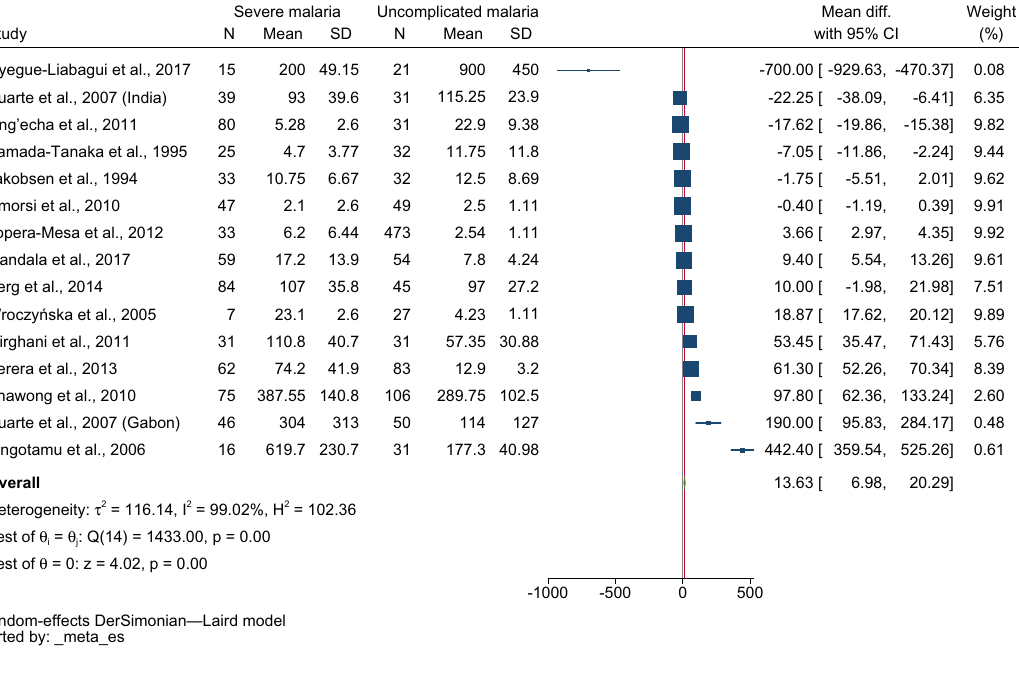
Figure 2. Forest plot demonstrating the pooled MD of INF-γ levels between patients with severe and uncomplicated malaria. CI confidence interval, SD standard